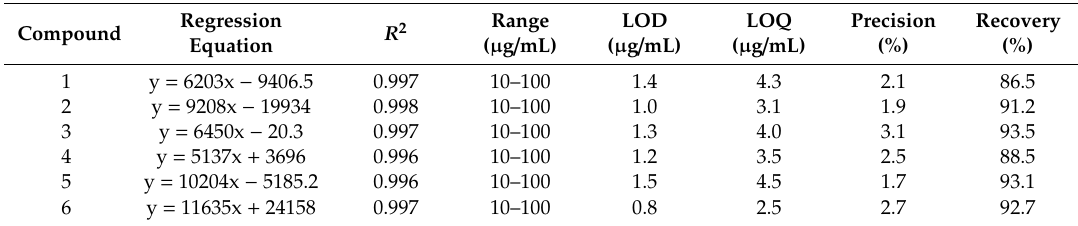
Table 2. Linear regression equations, coe ffi cients, linear range, precisions and recovery yields, limit of detection and limit of quantification of six phenolics.